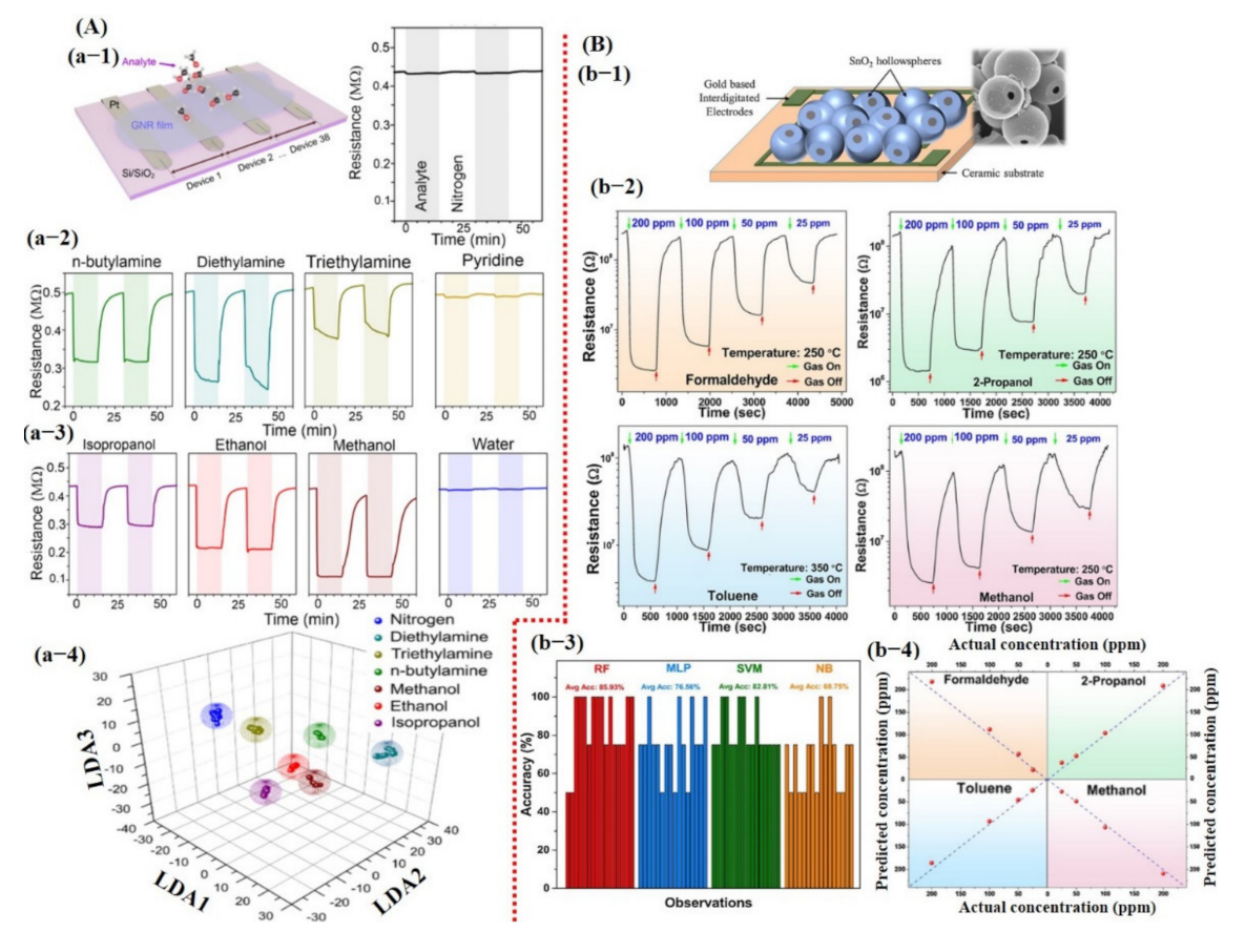
Figure 16. ( A , B ) summarize the detection results for different VOCs using chemiresistive devices and machine learning. (a-1) Schematic diagram of graphene nanoribbon sensors. (a-2) Real-time resistance change response toward different amines and alcohols. (a-3) 3D LDA graph representation with 100% accuracy. Reproduced with permission from [129], copyright 2020 ACS. (b-1) Schematic diagram of fabricated hollow SnO 2 sphere-based chemical sensor; inset presents the SEM image of synthesized hollow spheres. (b-2) Real-time resistance change response to different chemicals at various concentration levels. (b-3) Average accuracy bar graph for each model. (b-4) Representation of concentration prediction for each chemical. Reproduced with permission from [126], copyright 2020